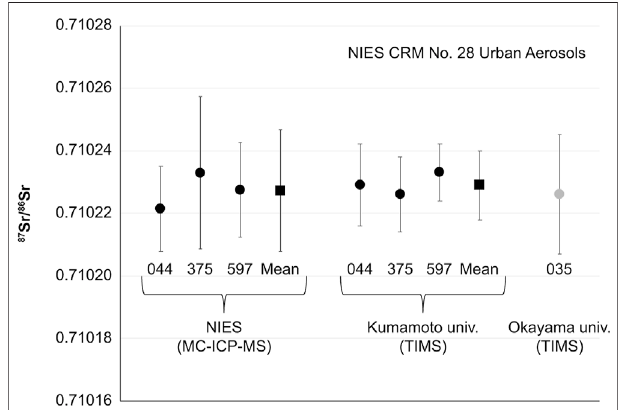
FIGURE 1 | 87 Sr/ 86 Sr ratios of NIES CRM No. 28 Urban Aerosols. All Sr isotopic data were adjusted to the NIST SRM 987 87 Sr/ 86 Sr value of 0.710248.